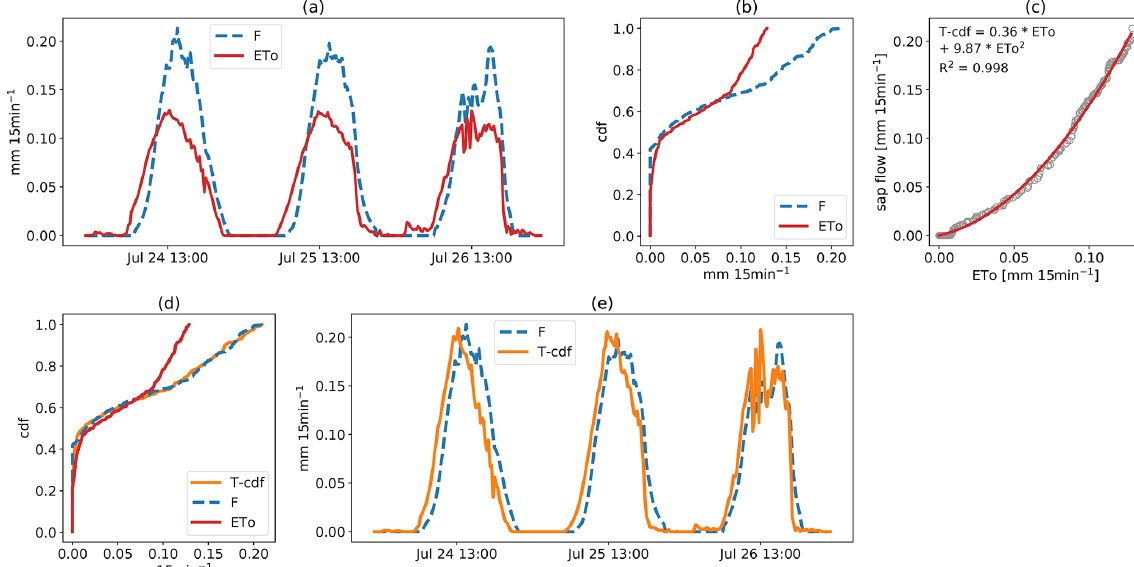
Figure 4. Example of ET 0 rescaling to approximate transpiration (2019 campaign), using the CDF matching approach. (a) Sap flow ( F ) and reference evapotranspiration (ET 0 ) data from 24–26 July 2019. (b) Cumulative distribution function (CDF) of both data sets in this period. (c) Second-order polynomial fit through ranked F and ET 0 data, used to derive the CDF-matched transpiration estimate (T-cdf), which was added to the CDF plot in panel (d) . Panel (e) shows the final result of the CDF matching.